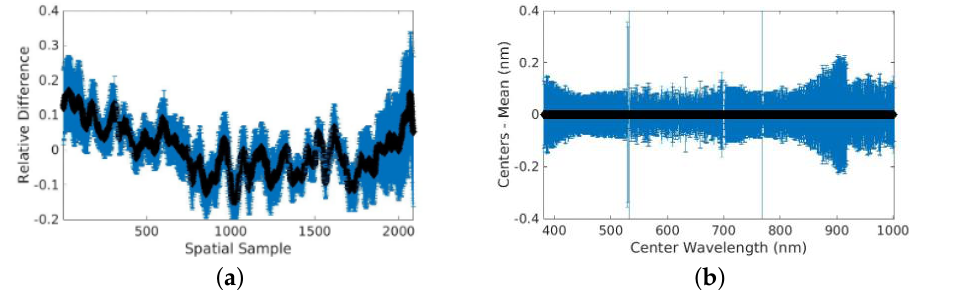
Figure 11. The average and standard deviation of the relative center wavelengths for ( a ) all of the spectral channels per spatial sample and ( b ) all of the spatial samples per spectral channel denoted by the corresponding center